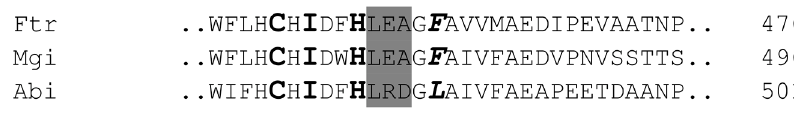
Figure 2. Partial amino acid alignment of LccFtr ( Funalia trogii ), LccMgi ( Meripilus giganteus ) and LccAbi ( Agaricus bisporus ). Bold letters show three out of four invariable T1 copper ligands, bold and italic letters the variable axial ligand and letters highlighted in grey a characteristic tripeptide of the binding site of T1 copper indicative of the redox potential of the respective